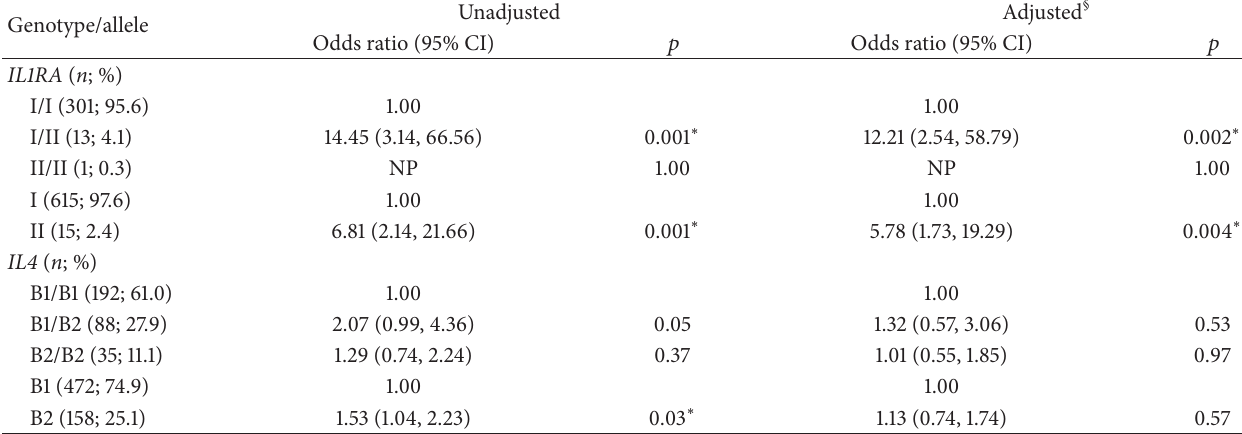
Table 3: Logistic regression analysis for the association of IL1RA and IL4 VNTR with overall adiposity status. Unadjusted Adjusted § Genotype/allele Odds ratio (95% CI) 𝑝 Odds ratio (95% CI)